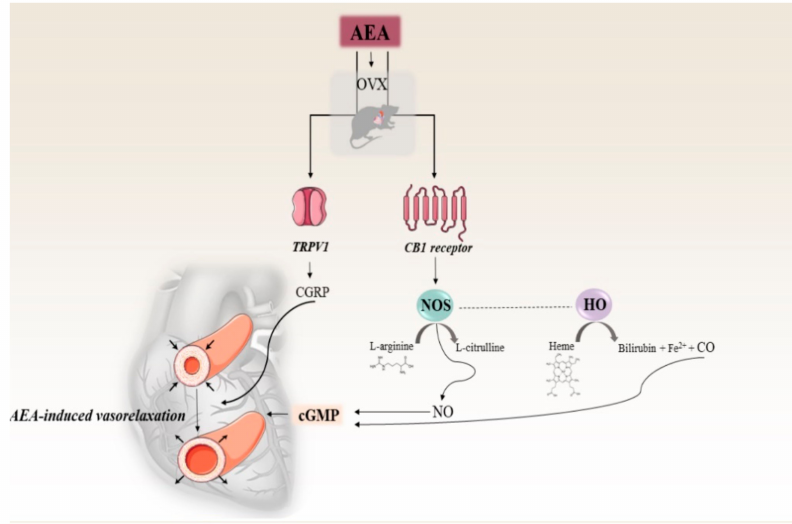
Figure 6. E ff ects of anandamide on NOS / HO systems, and TRPV1 / CGRP pathway in an estrogen-deficient rat model. short arrows indicate changes of the diameter of the vessels. AEA = anadamide, OVX = surgical ovariectomy, TRPV1 = transient receptor potential vanilloid 1, CGRP = calcitonin gene related peptide, CB1 receptor = cannabinoid 1 receptor, cGMP = cyclic guanosine monophosphate, NOS = nitric oxide synthase, HO = heme oxygenase, NO = nitric oxide, CO = carbon